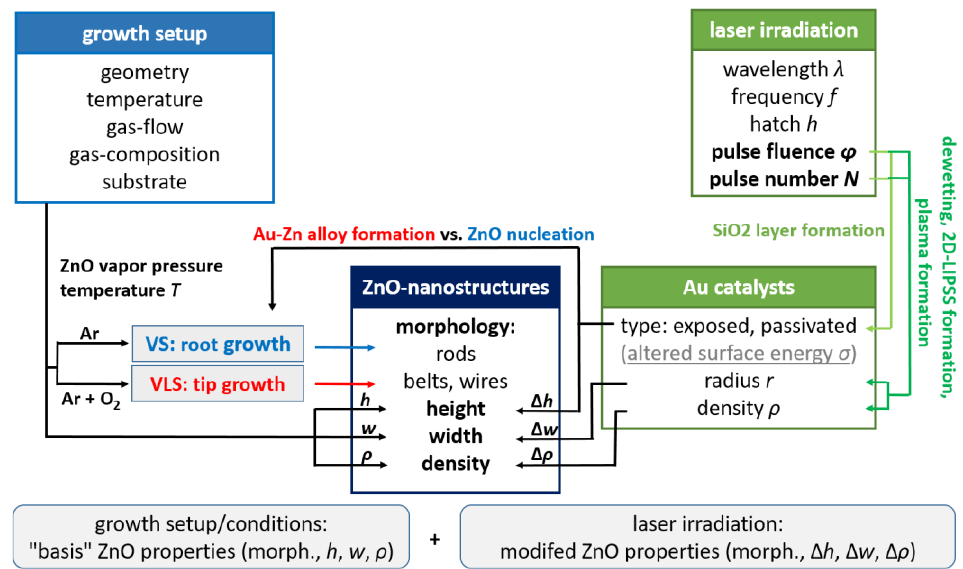
Figure 11. Schematic representation of the spatial-selective laser irradiation’s effect on ZnO nanostructure growth as compared to the growth setup and conditions. Note that additional cross-relations, which are of less importance and thus not illustrated, may occur.